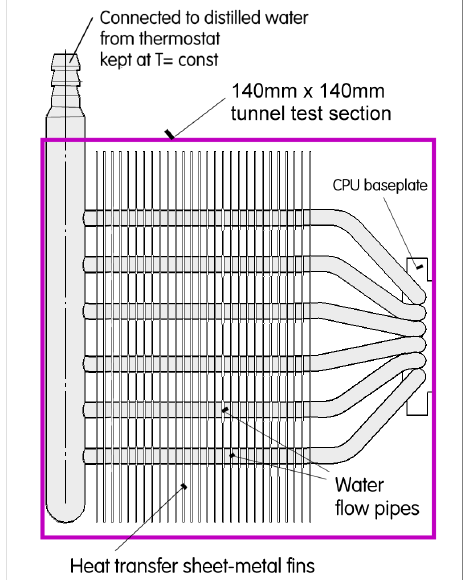
Fig. 20. Layout of the dual air heater. Water from the thermostat is distributed in each part of the heater by six pipes to a series of parallel thin aluminium fins. The original baseplate for CPU was retained despite its now having no useful